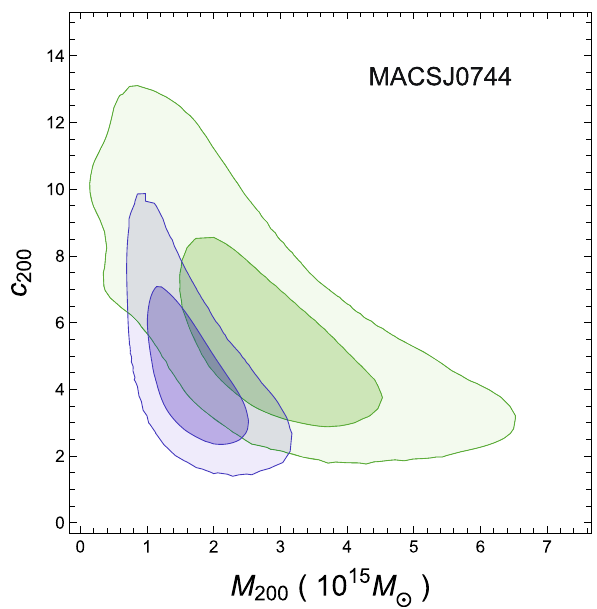
Fig. 6 Contour plot: blue—GR; green—nonlocal